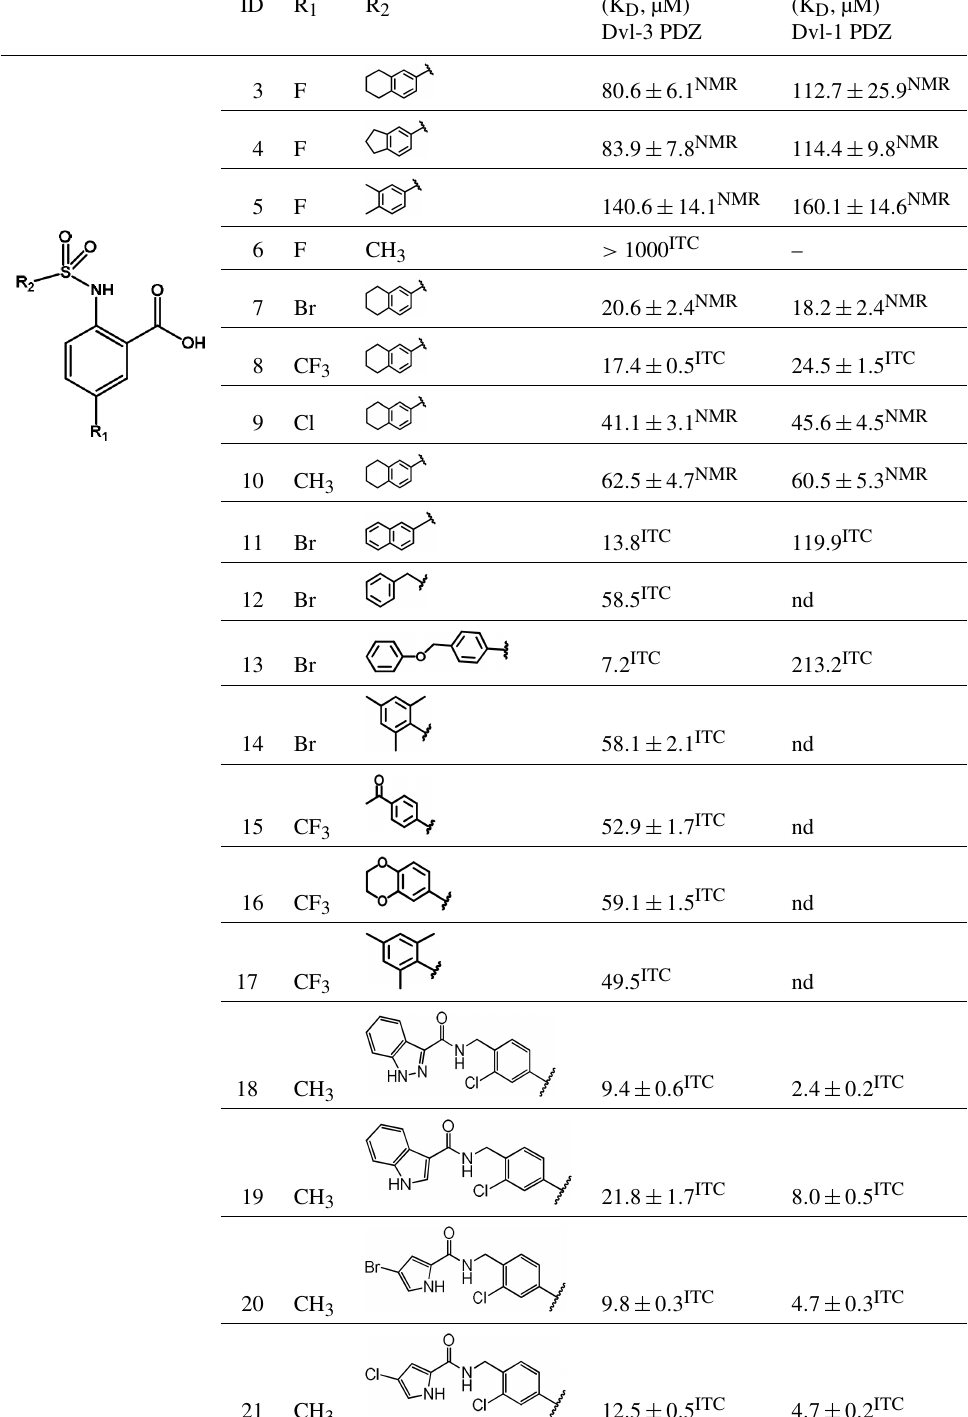
Table 1. Binding constants K D (µM) of Dvl-3 PDZ and Dvl-1 PDZ for compounds 3 – 21 derived by ITC or NMR if not specified. The K D values determined by NMR are reported as means ± standard deviations of measurements evaluating shifts of cross peaks of at least six residues influenced upon binding of the ligand. The K D values (1 / K A ) determined by ITC were obtained as fits to a one-site binding model ( n in the range of 0.95–1.2) with K D errors obtained by (cid:49) K A / K A2 . ID R